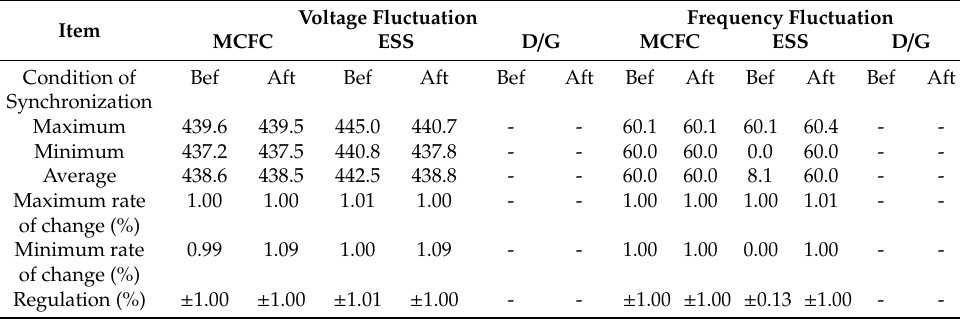
Table 11. Power data analysis before and after ESS synchronization.